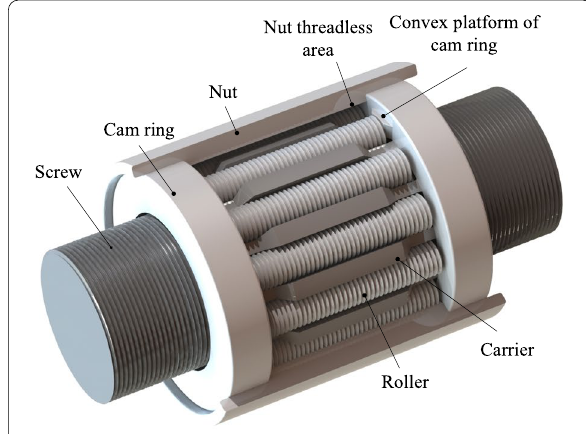
Figure 2 RPRSM three-dimensional model